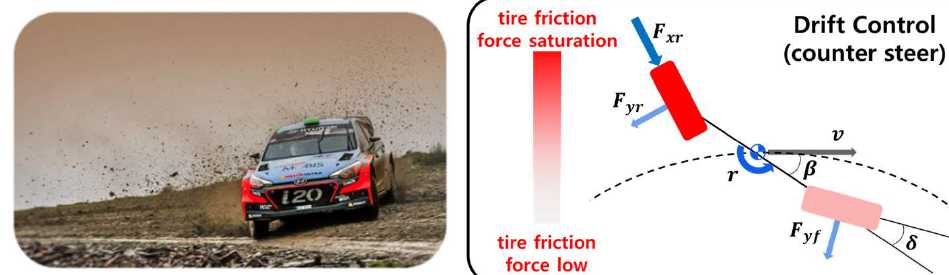
Figure 2. Drift control maneuver.